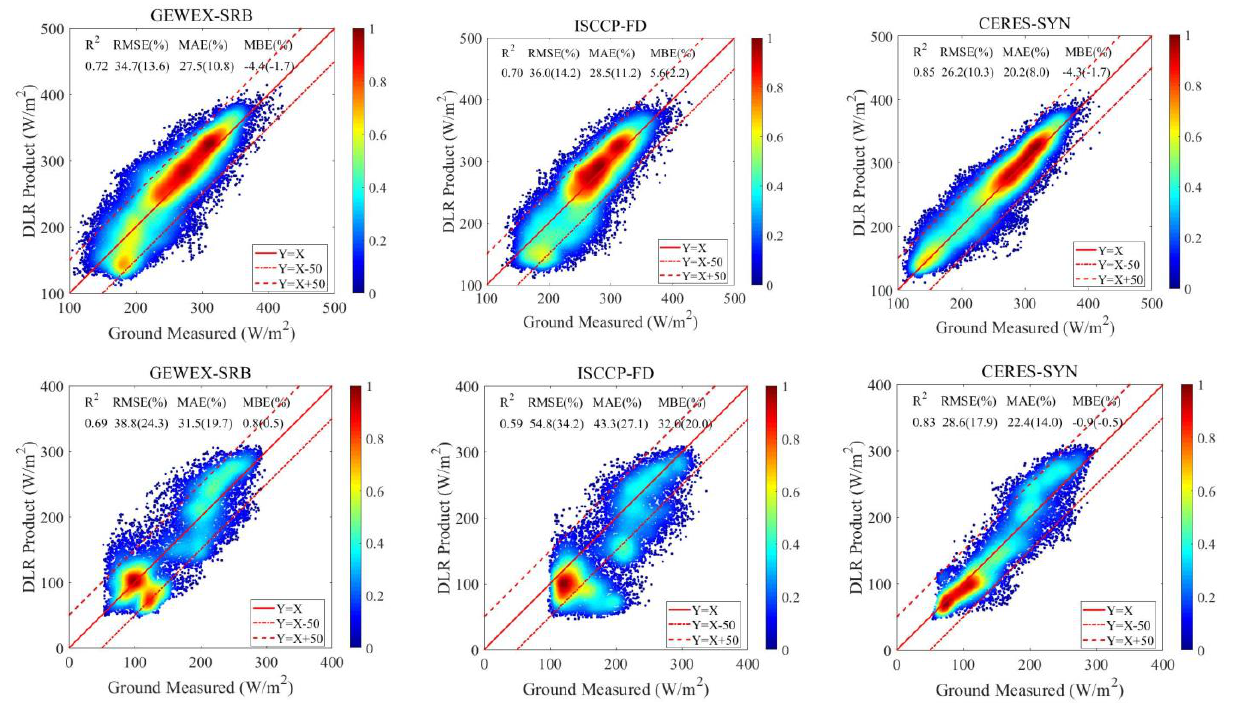
Figure 3. The overall scatterplots of DLR products in the polar regions. The top figures represent the results in Arctic, and the bottom figures represent the results in Antarctic. The color represents the data density.